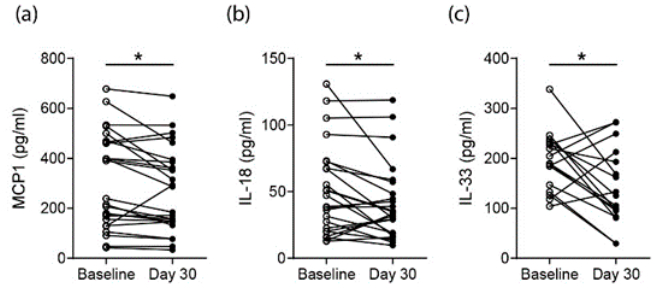
Figure 3. Decreased proinflammatory cytokines following long-term 30-day high-fiber diet supplementation in RA patients ( n = 29). ( a ) MCP-1 (CCL2), ( b ) IL-18 and ( c ) IL-33 serum concentrations in RA patients at baseline and day 30 following high-fiber supplementation. Statistical difference was determined by a paired Students t -test (Wilcoxon matched-pairs signed rank test). *= p < 0.05; ** = p < 0.01; *** = p <